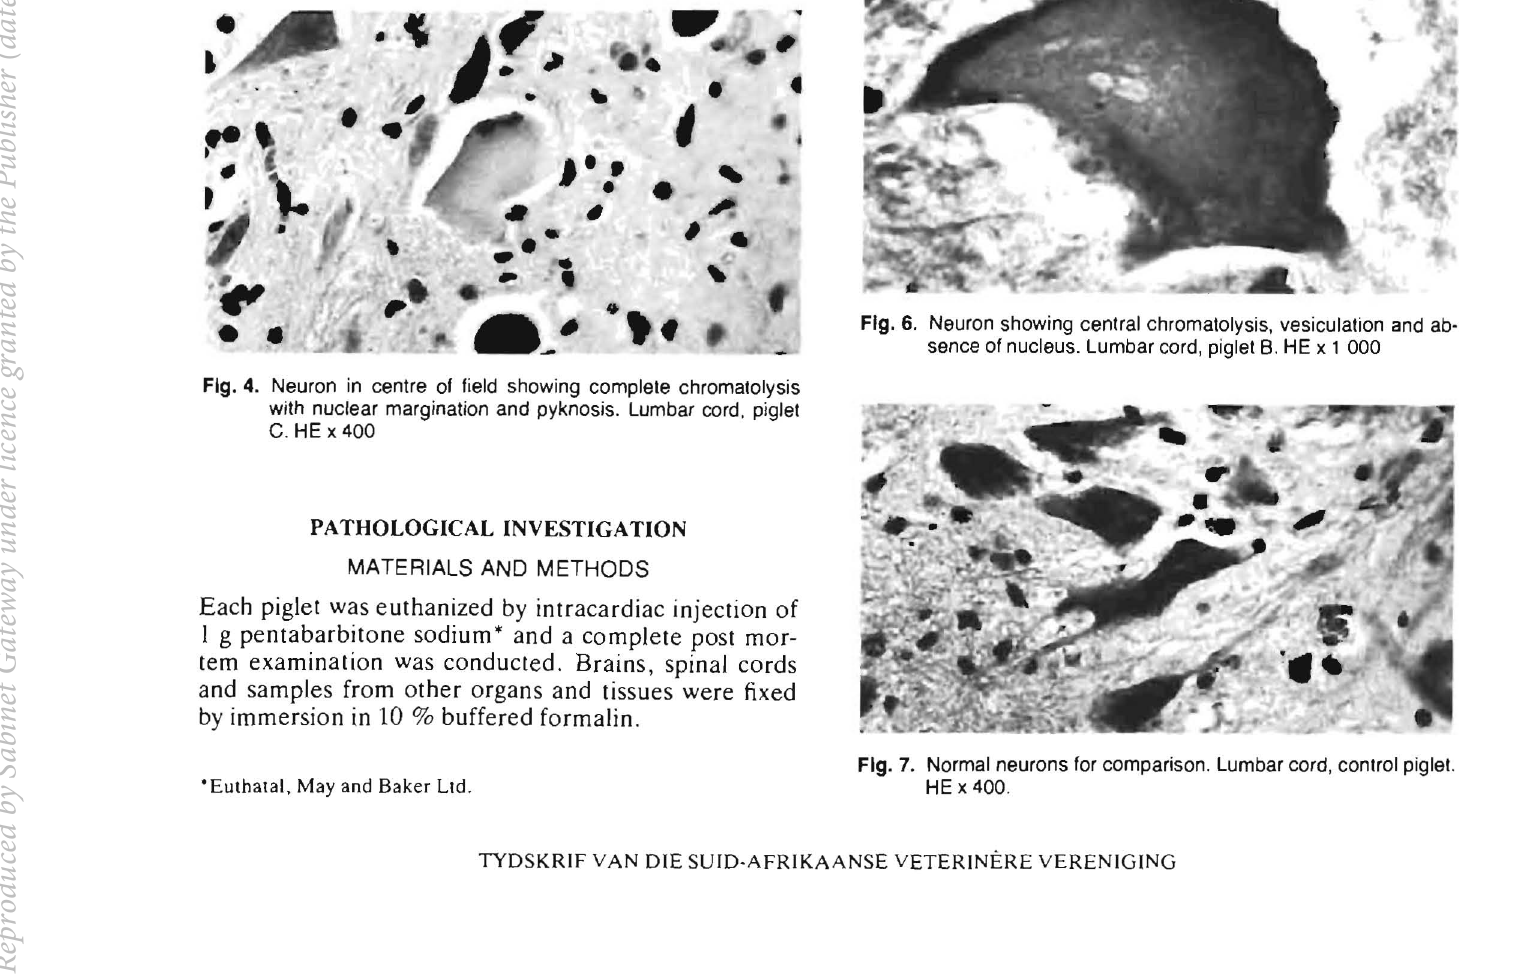
Fig. 6. Neuron showing central chromatolysis. vesiculation and ab sence of nucleus. Lumbar cord, piglet B. HE x 1 000